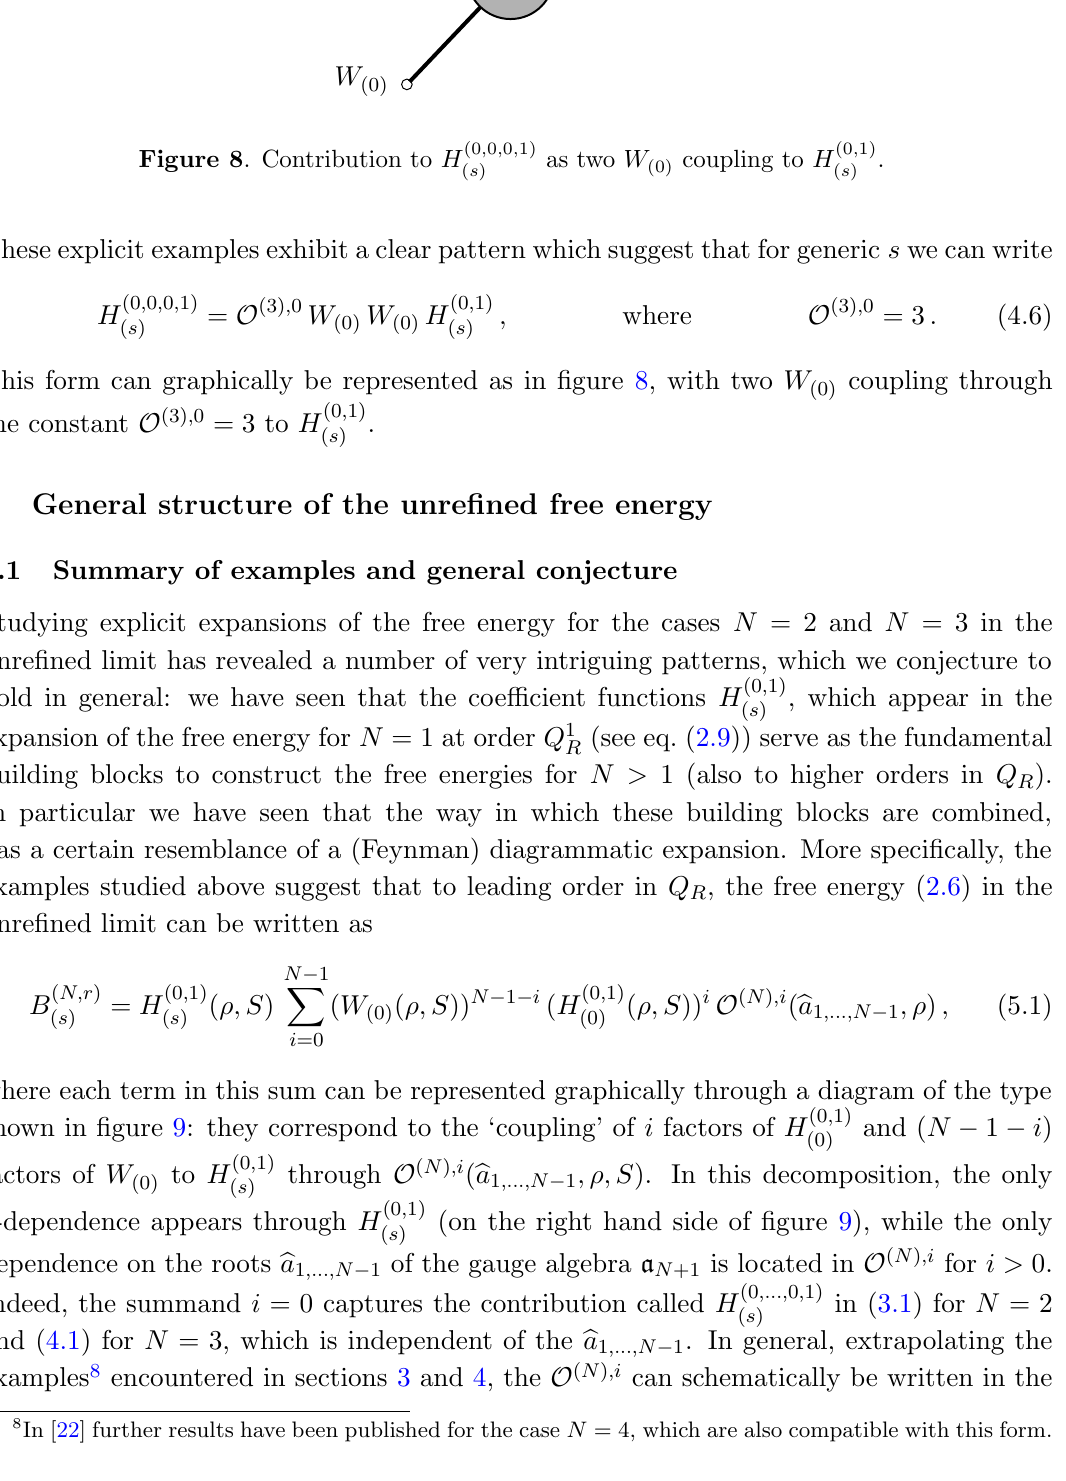
Figure 8 . Contribution to H (0 ; 0 ; 0 ; 1)